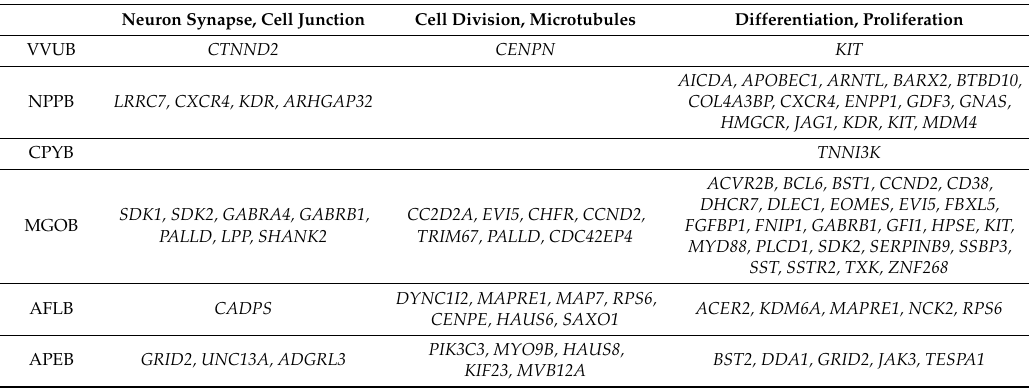
Table 4. Selected B chromosome gene functions. Neuron synapse and cell cycle proteins retrieved from DAVID Gene ontology (GO) clustering results, while differentiation and proliferation proteins are listed based on keyword match in the GO